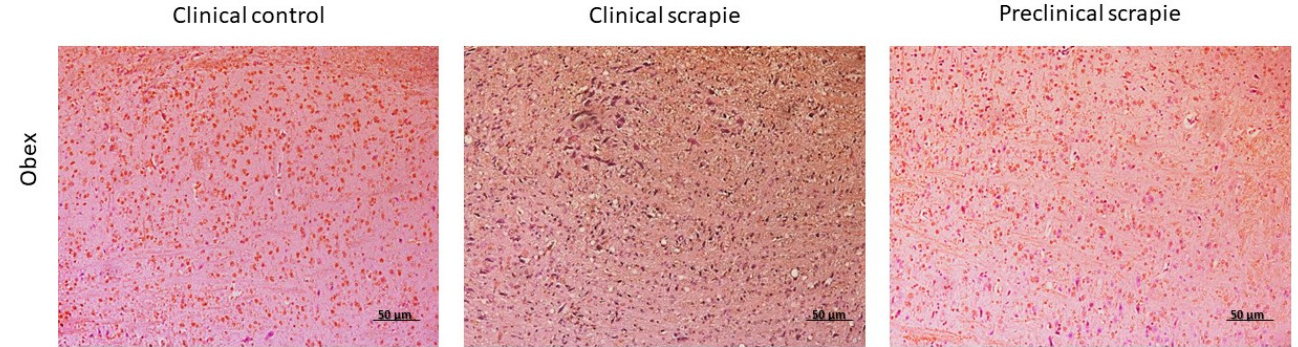
Figure 5. Representative images of 5mC immunostaining in the obex of clinical control mice and clinical and preclinical mice.